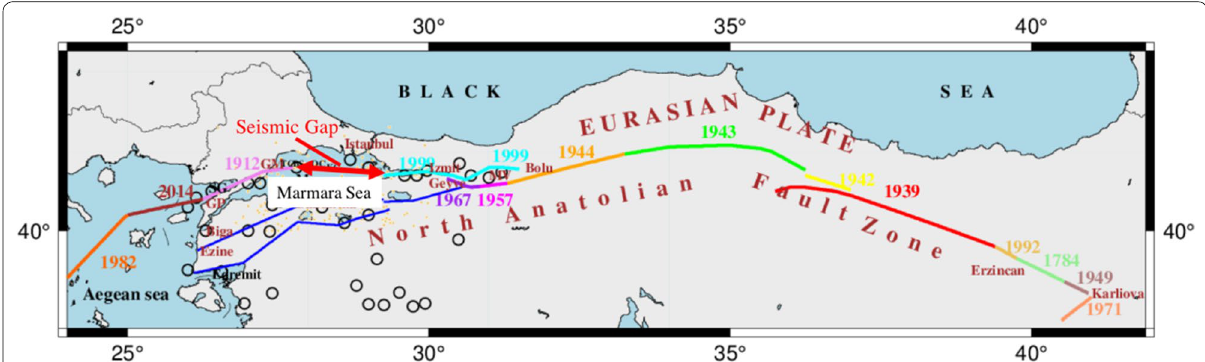
Fig. 1 Surface rupture extent associated with major earthquakes along